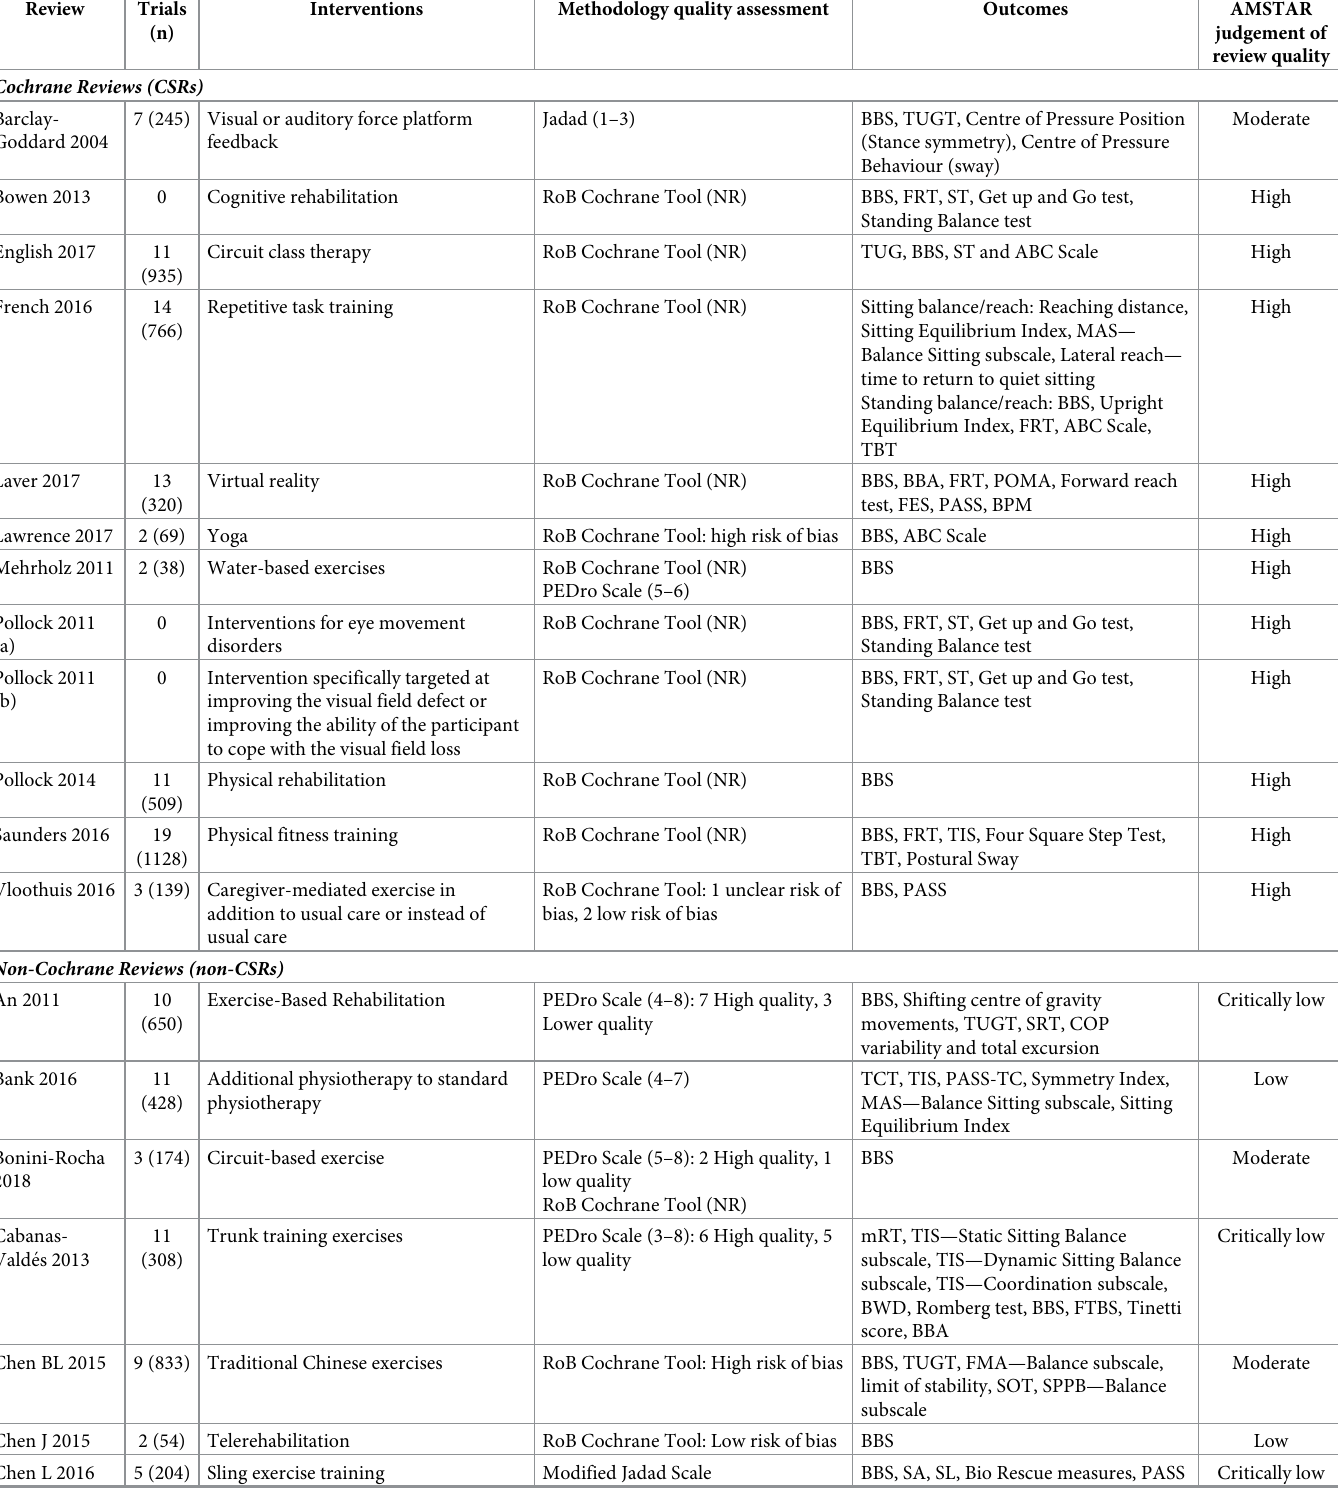
Table 1. Overview of key characteristics of included